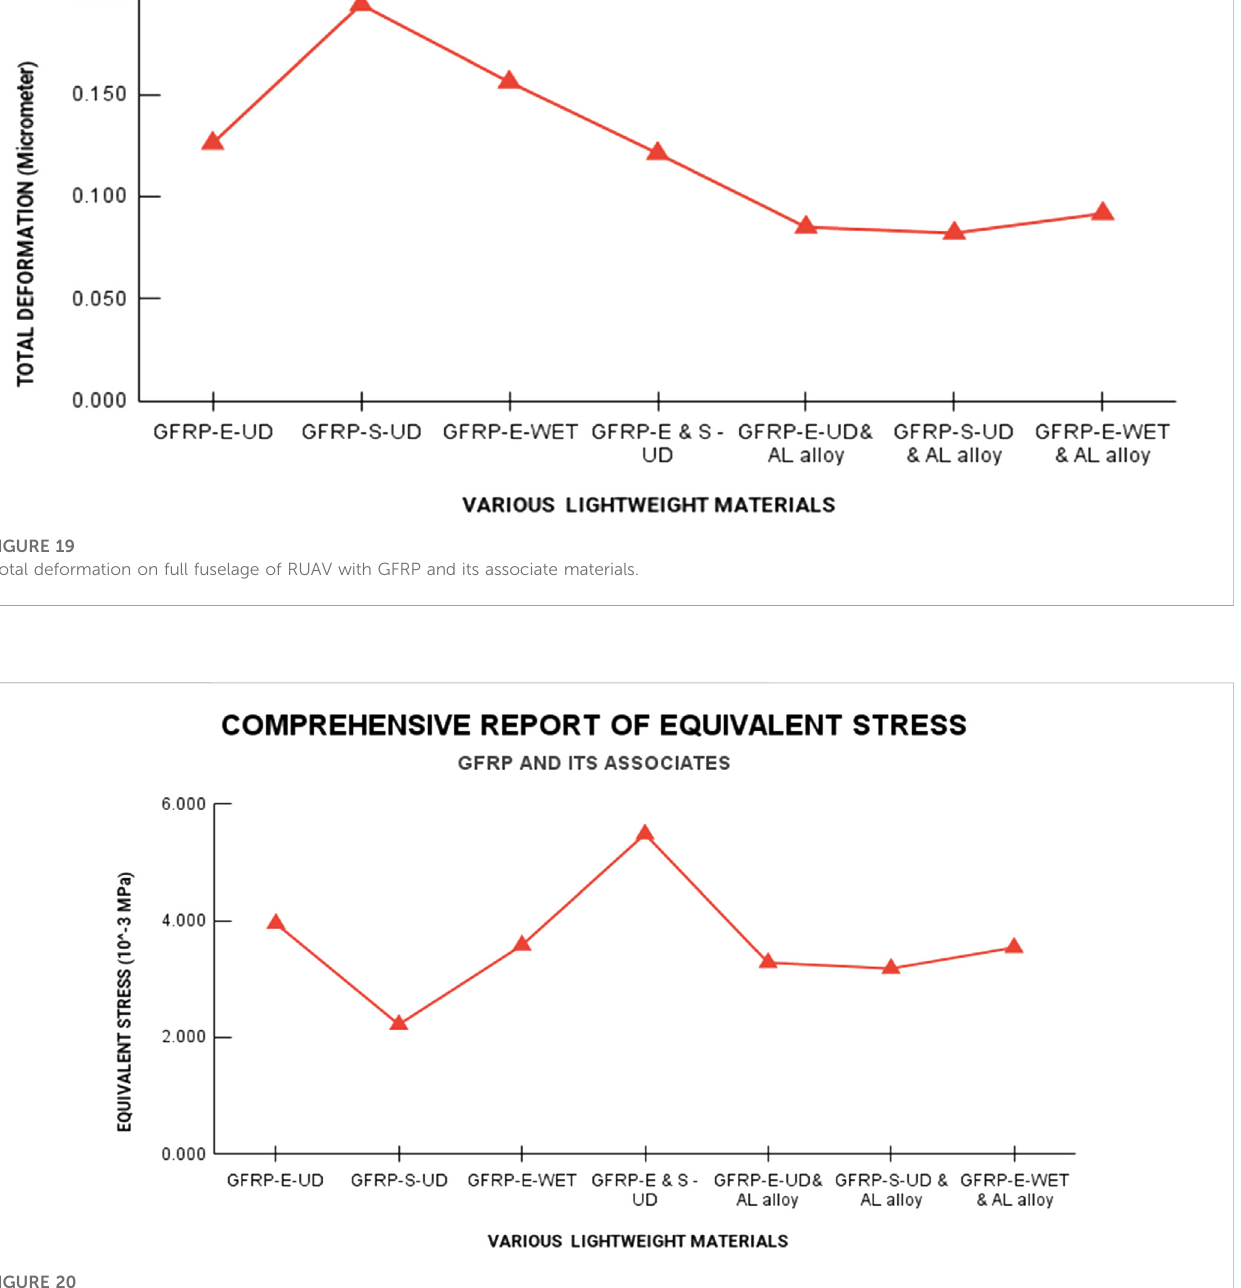
Equivalent stress on full fuselage of RUAV with GFRP and its associate